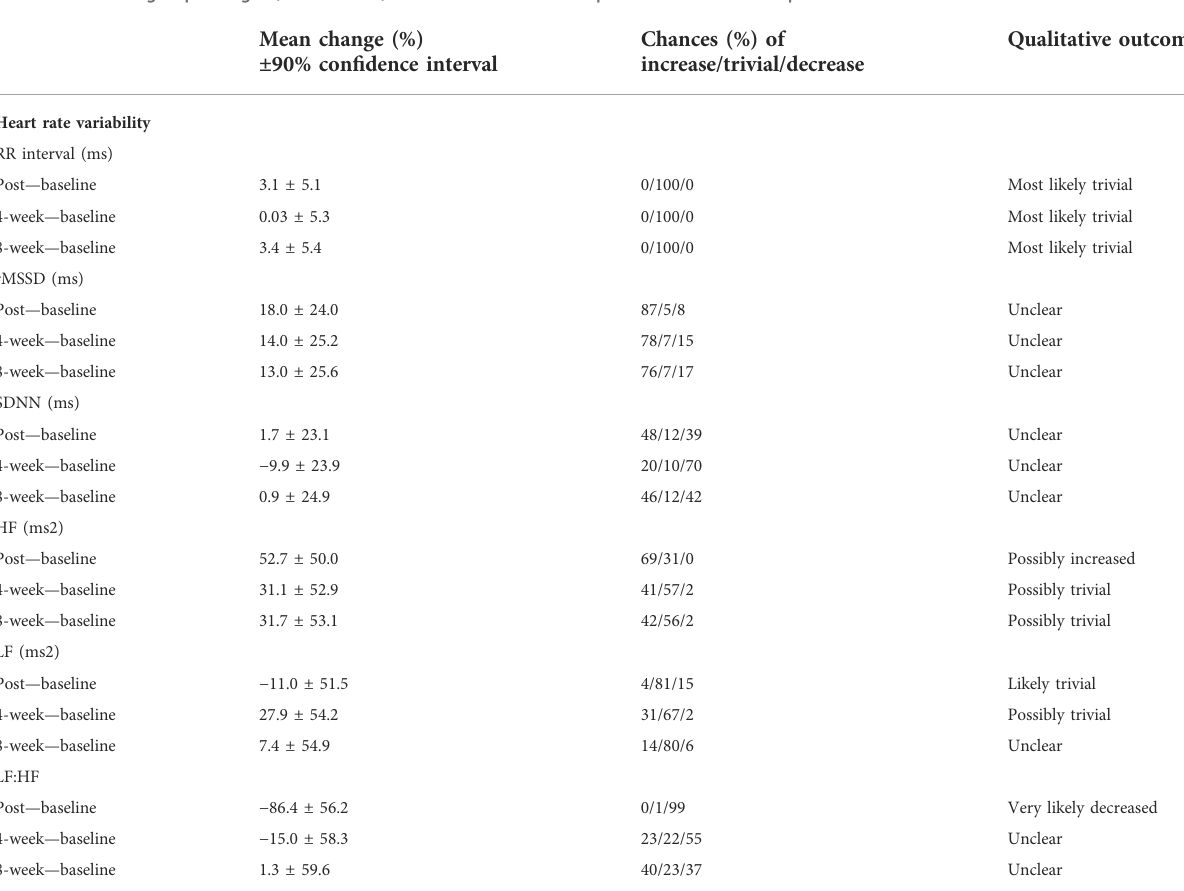
TABLE 4 Between group changes (IHE + Ex – Ex) in HRV from baseline to post-intervention time points.